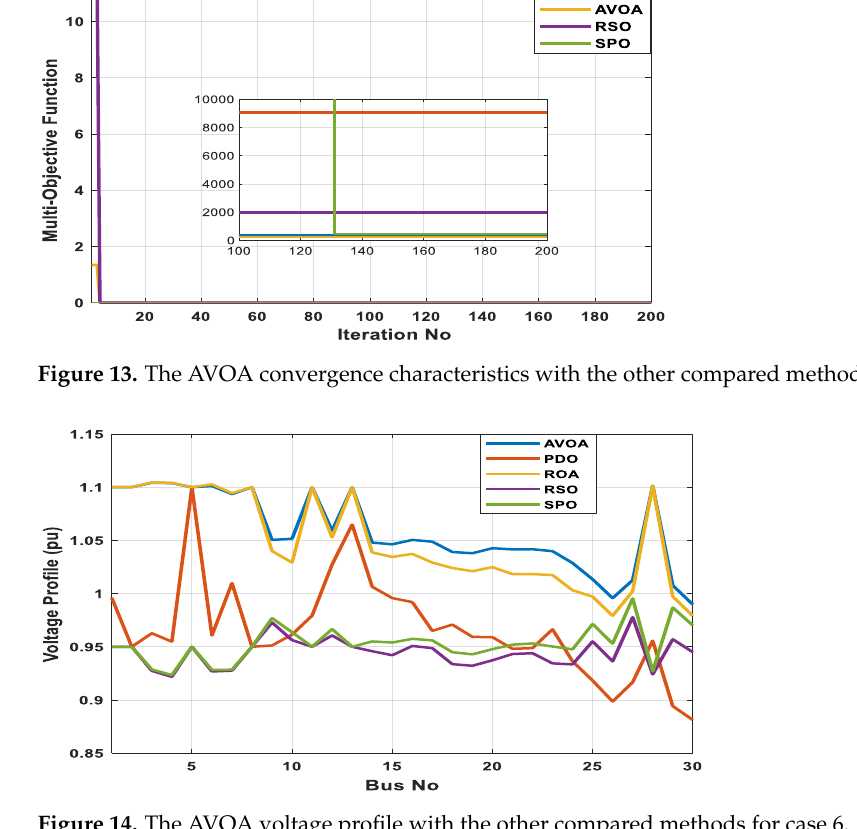
Figure 14. The AVOA voltage profile with the other compared methods for case 6. Table 19. Minimization of multi-objective functions (voltage-level deviation, operational cost, and transmission power loss) with discrete control variable settings in IEEE-30 bus.